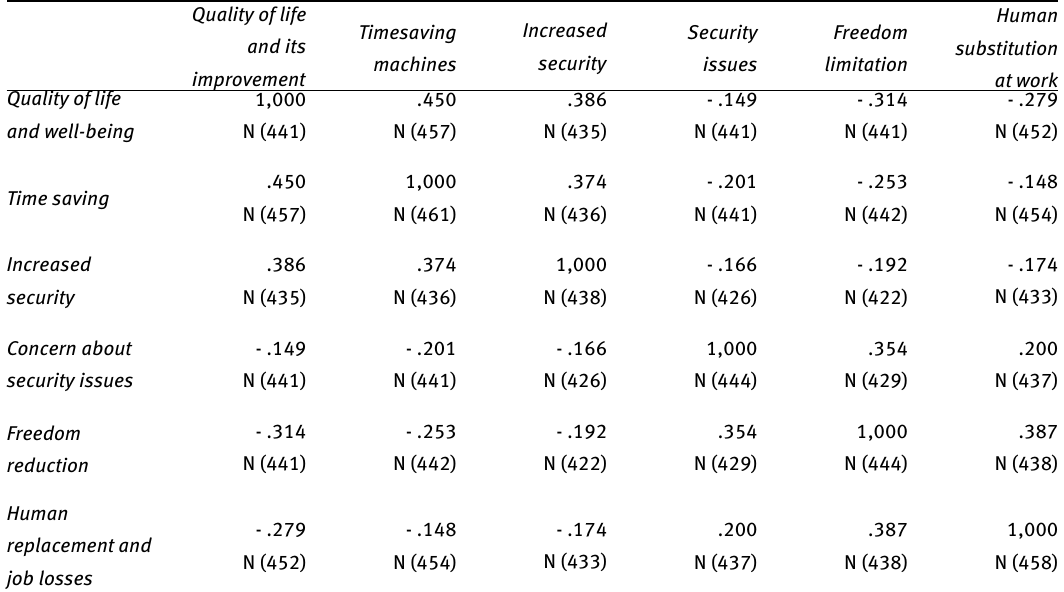
Table 10: Correlation (Pearson’s r) between